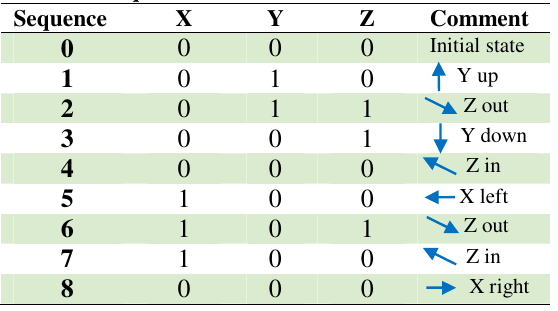
Reference sequence for the second obstacle .